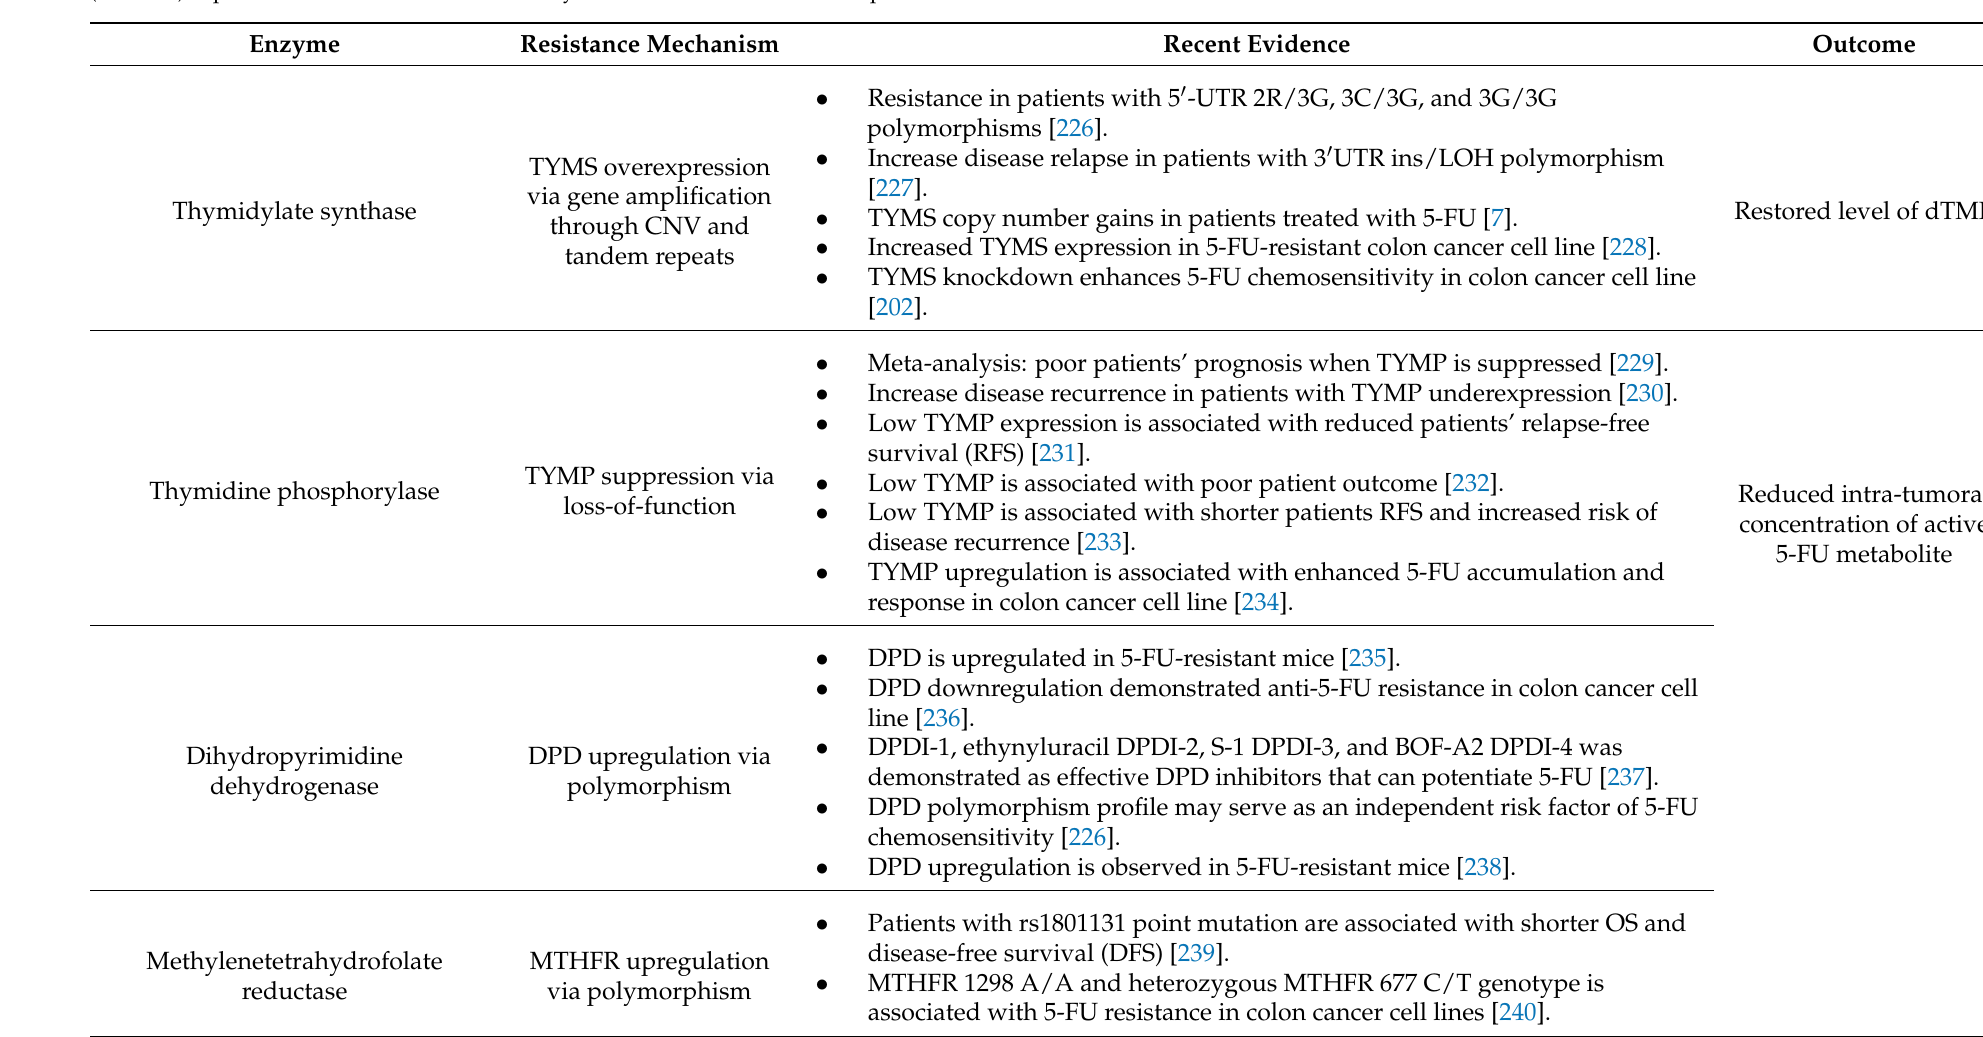
Table 2. Recent evidence on the correlation of thymidylate synthase (TYMS), thymidine phosphorylase (TYMP), dihydropyrimidine dehydrogenase (DPD), and methylenetetrahydrofolate reductase (MTHFR) expression with 5-FU chemosensitivity in colon cancer cell lines and